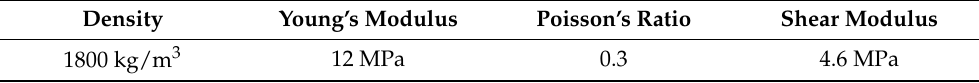
Table 1. Soil parameters utilized for model verification and parametric studies.